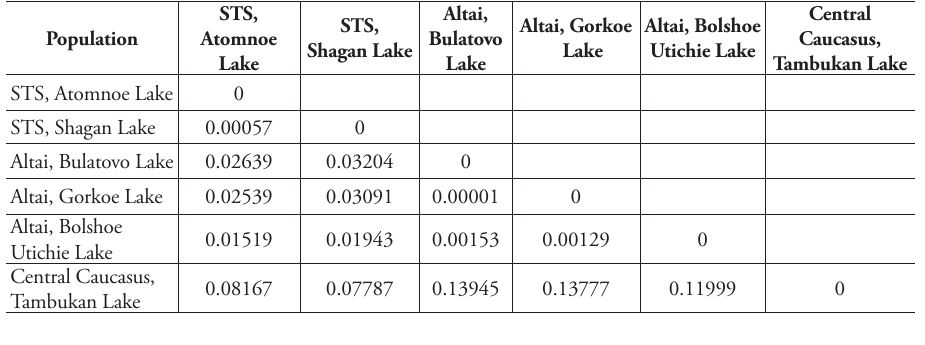
Table 3. Value of genetic distances between the different populations of G. salinus .